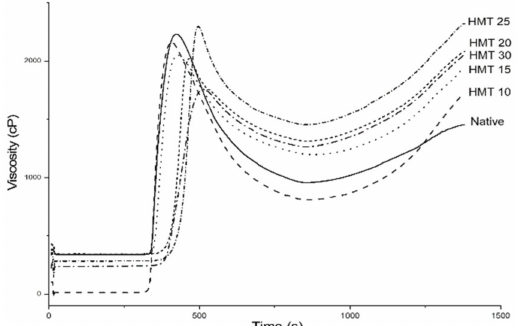
Figure 2. Pasting properties of native and HMT sago starch samples. Native indicates native starch, HMT indicates heat-moisture treatment starches. HMT 10, HMT 15, HMT 20, HMT 25, and HMT 30 indicate the starch samples treated with HMT for the 10%, 15%, 20%, 25%, and 30% moisture treatments, respectively.